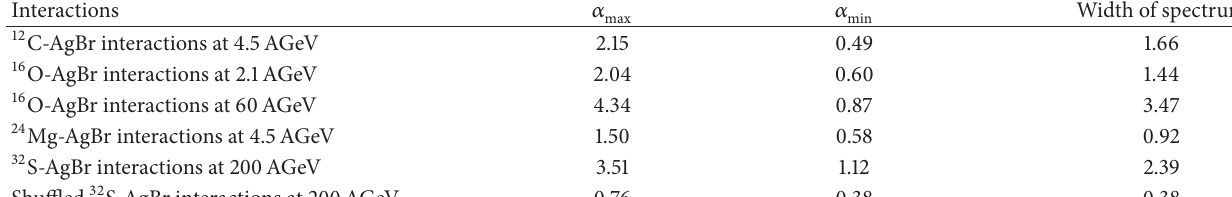
Table 2: Width of multifractal spectrum for different interactions.